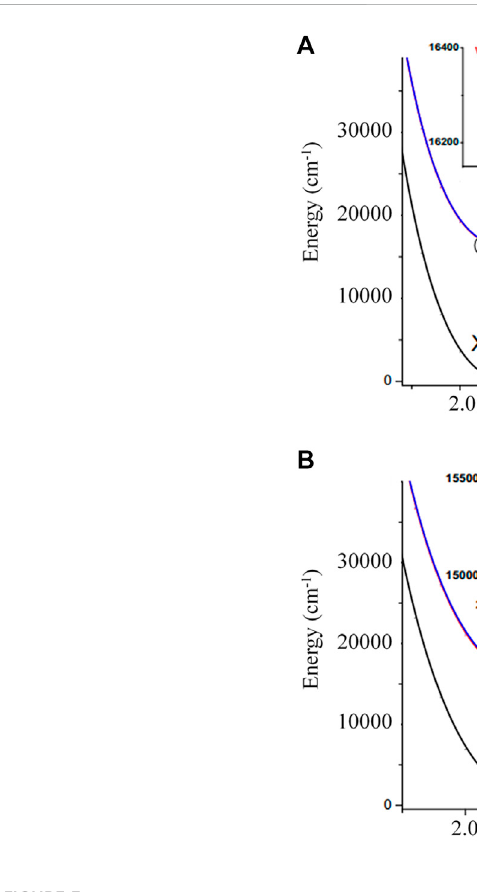
FIGURE 3 PotentialenergycurvesfortheX 2 Σ 1/2 + ,A 2 Π 1/2 andA 2 Π 3/2 statesof (A) CaNCand (B) SrNCobtainedby fi xingotherparameterswhenscanningthe M-N bond